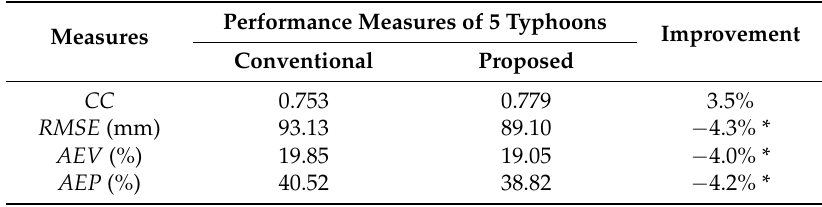
Table 3. Improvement due to the use of the proposed strategy instead of the conventional